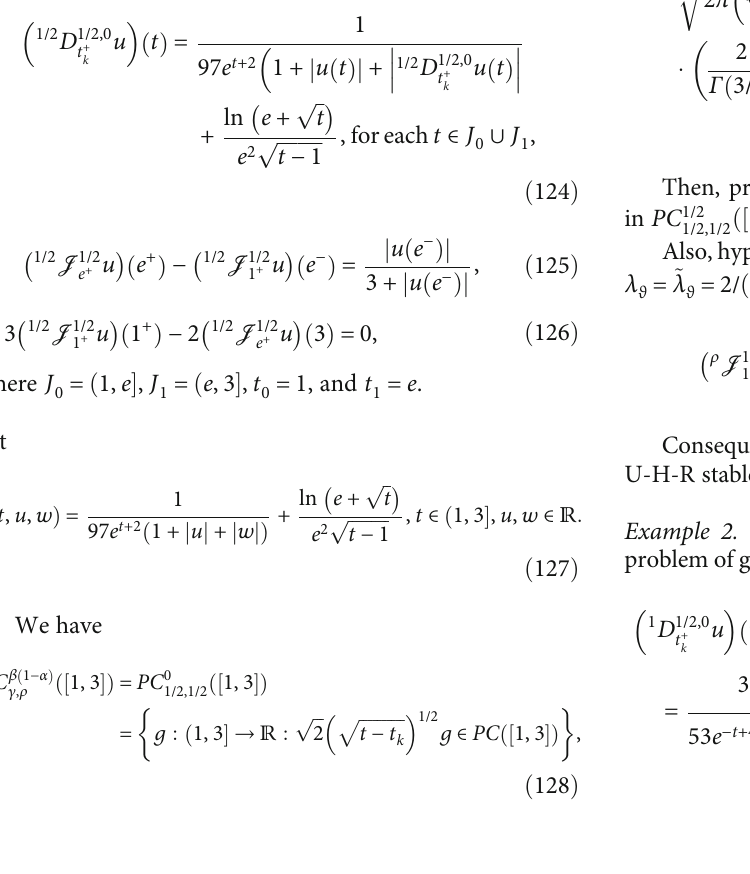
1 ffiffiffiffiffiffiffiffiffi